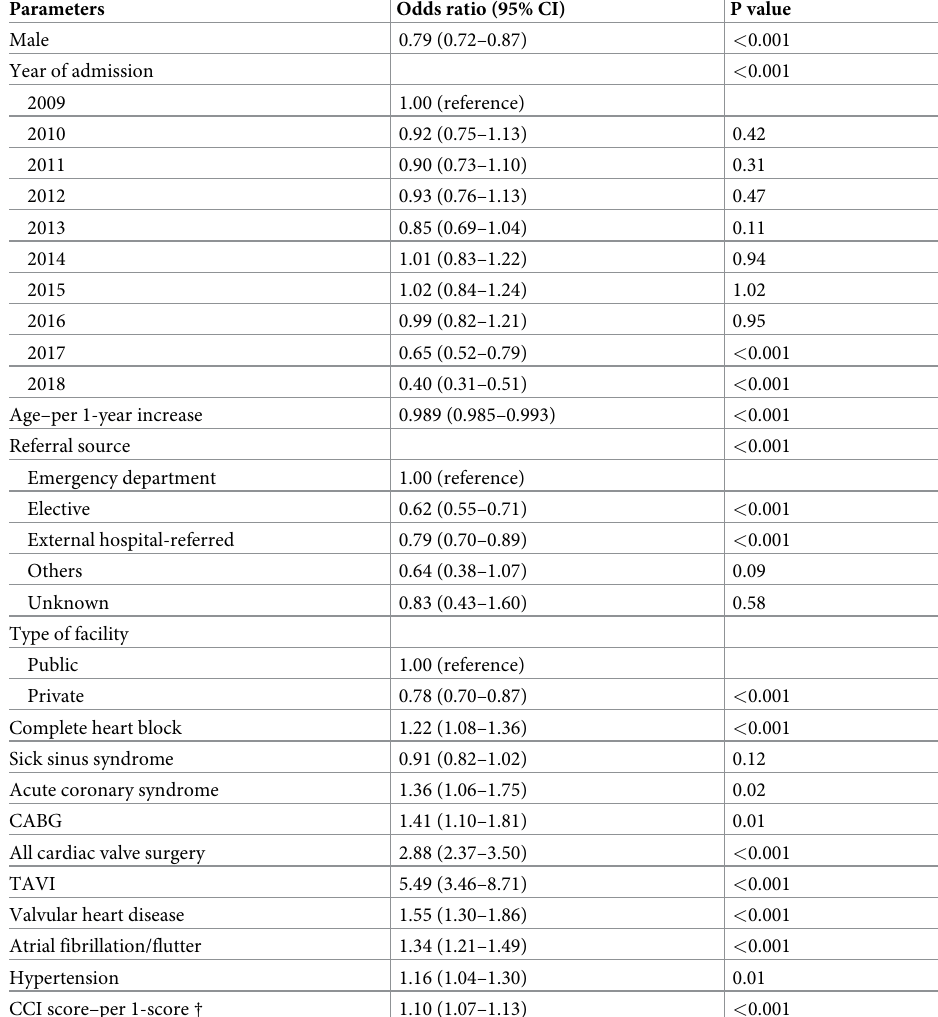
Table 3. Independent predictors for total in-hospital non-fatal complications �